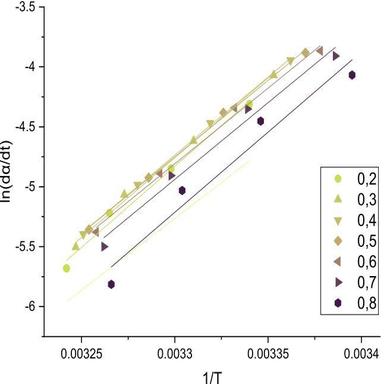
Friedman plots resulting from the isoconversional analysis for selected α values of the experimental curves presented in Fig. 2.